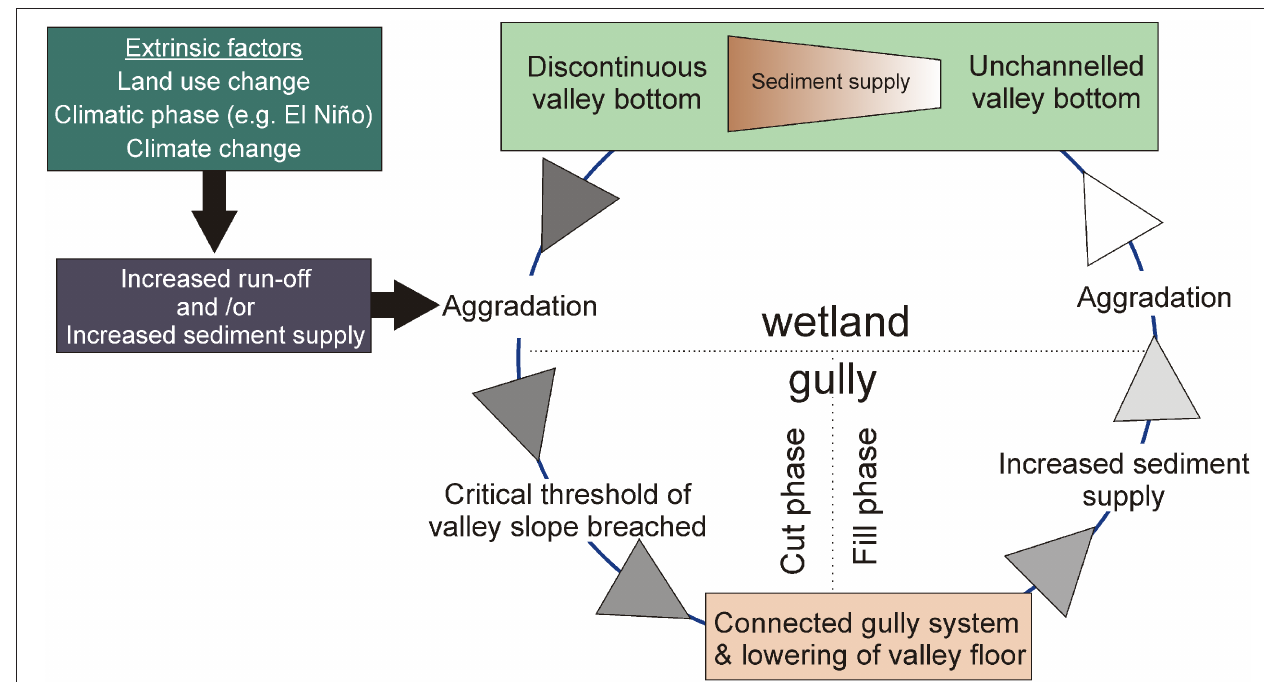
FIGURE 8 | In an example of self-organised criticality, aggradation in valley-bottom wetlands results in valley steepening. Ongoing aggradation eventually results in incision once a particular valley slope threshold is breached. The release of valley fill sediment through erosion causes aggradation downstream, eventually resulting in the formation of new valley-bottom wetlands. Whether the wetland is a discontinuous or unchannelled valley-bottom wetland may be related to catchment sediment supply during the fill phase, with discontinuous systems being characterised by a larger sediment